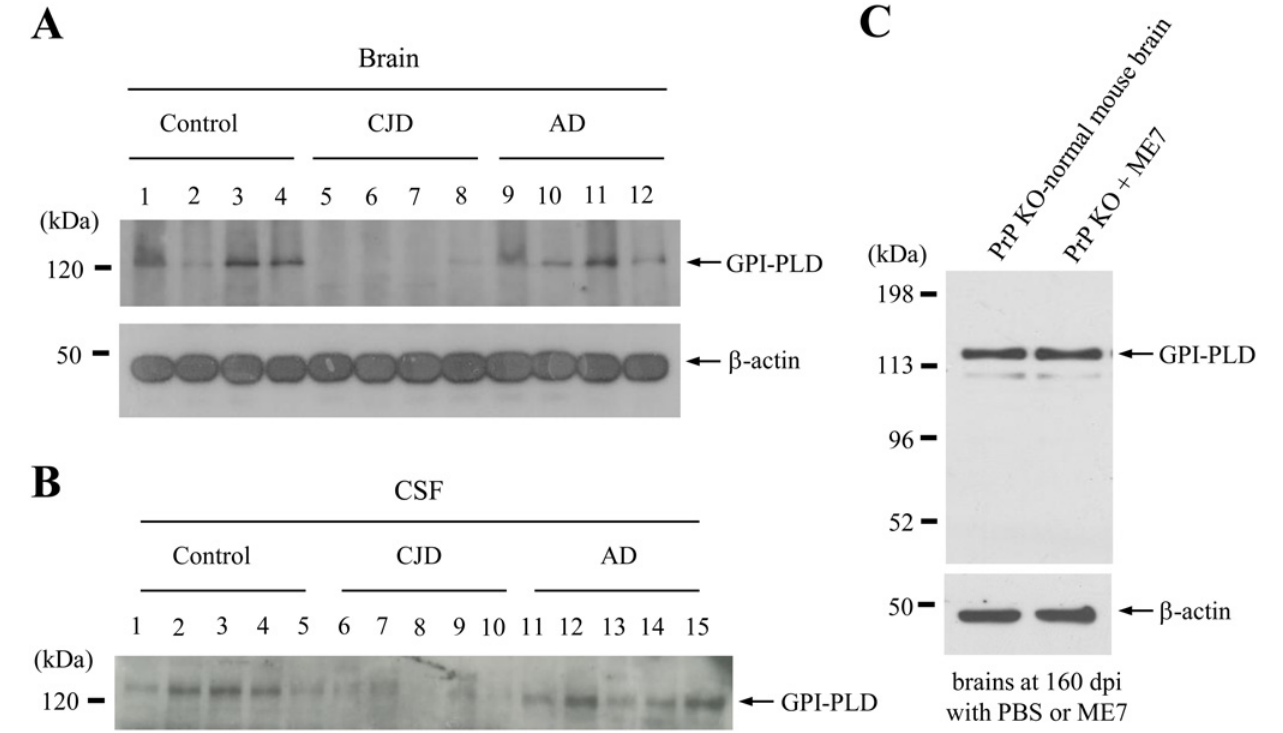
Fig 3. A decrease in GPI-PLD levels was observed in the brains and CSF specimens of CJD patients. Compared to controls, the level of GPI-PLD expression was decreased in brains (A) and CSF specimens (B) from CJD patients. In contrast, a change in GPI-PLD expression levels was not observed in the brains of either AD or normal/scrapie strain (ME7)-injected PrP knock out (PrP KO) (C) mice. All brain tissues were prepared as described in the Materials and Methods section and analyzed by Western blotting using the anti-GPI-PLD and anti-PrP 10E4 antibodies. All brains and CSF specimens shown in Table 1 were analyzed by Western blotting. β -actin detected by an anti- β -actin antibody was used as the